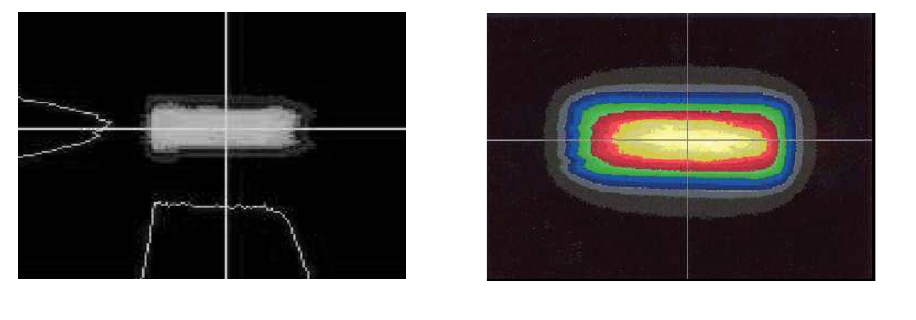
Figure 39. Typical rectangular excimer laser